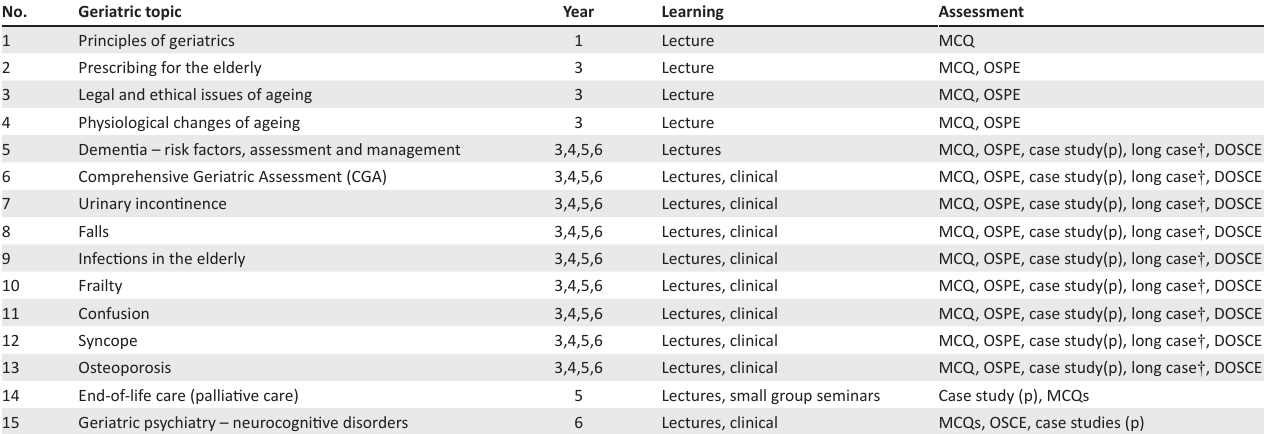
TABLE 1: Domains of geriatric care taught and assessed in the MBChB curriculum. No. Geriatric